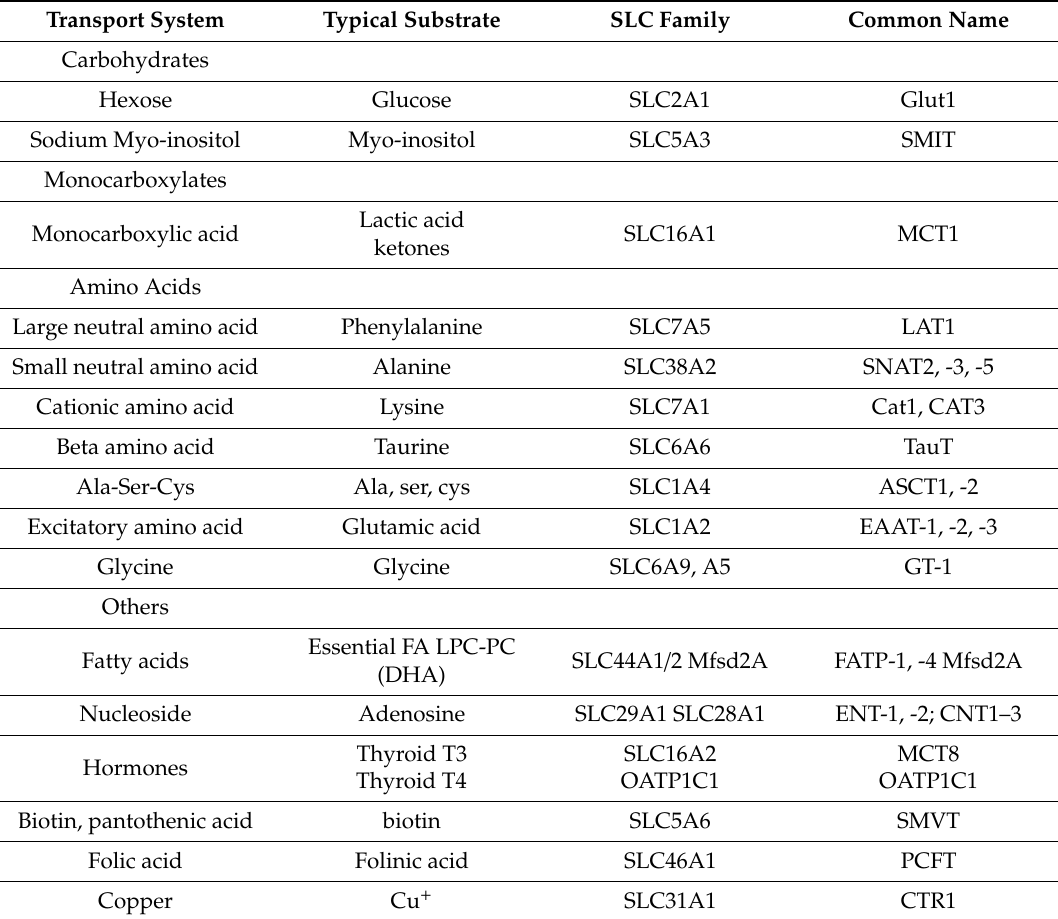
Table 1. Endothelial cell membrane transporters: partial list of common